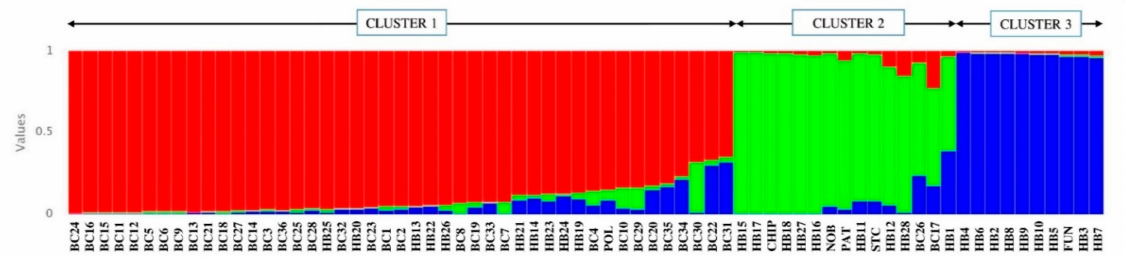
Figure 4. Distribution of blueberry genotypes as per STRUCTURE analysis (K = 3), based on the combination of EST–SSR, genomic (G)–SSR, and EST–PCR primer pairs. The genotypes are represented as vertical bars, and the colour represents different clusters (see Tables 1 and 2 for genotype